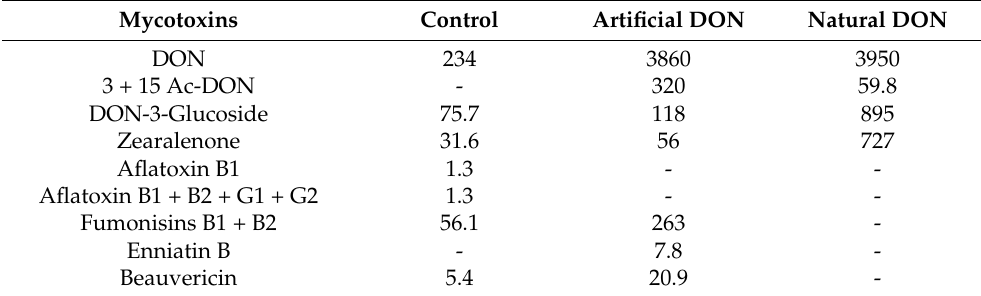
Table 2. Mycotoxins’ levels ( µ g/kg) in the experimental treatments in the grower period (D14–28). Mycotoxins Control Artificial DON Natural DON